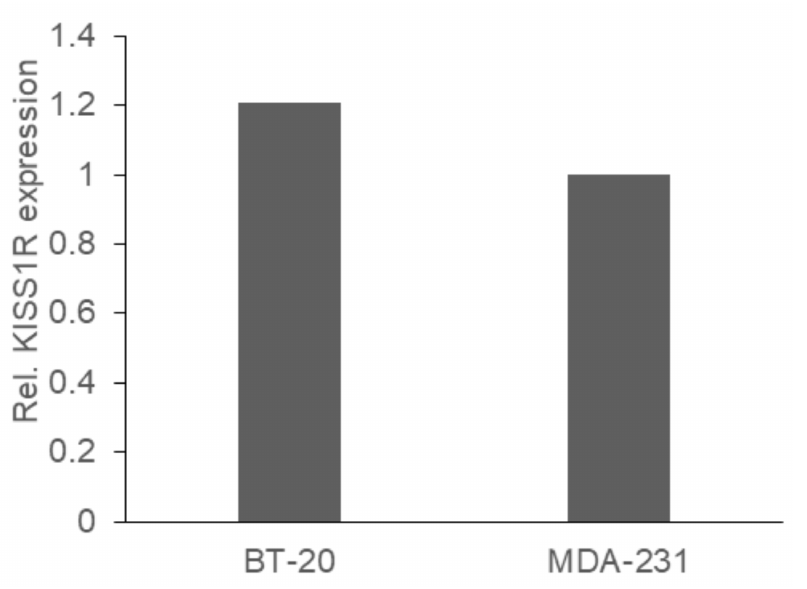
Figure 1. KISS1R mRNA is expressed in BT-20 and MDA-MB-231 cells. Total RNA was extracted from BT-20 and MDA-MB-231 cells and the mRNA was converted into cDNA using random hexamers. Quantitative real-time PCR was performed using SYBR green. The data were quantified with β -actin used as the housekeeping control. The graph represents the means from a single experiment, with three technical